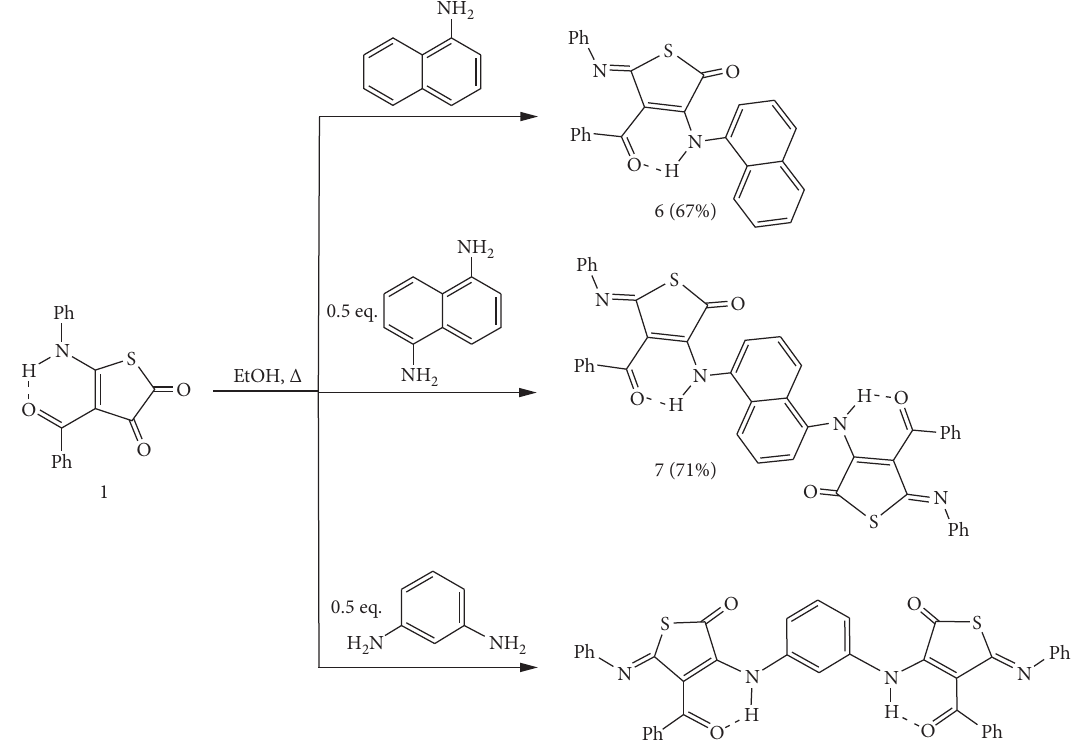
Scheme 3: Reactions of 1 with naphthylamines and 1,3-phenylenediamine.